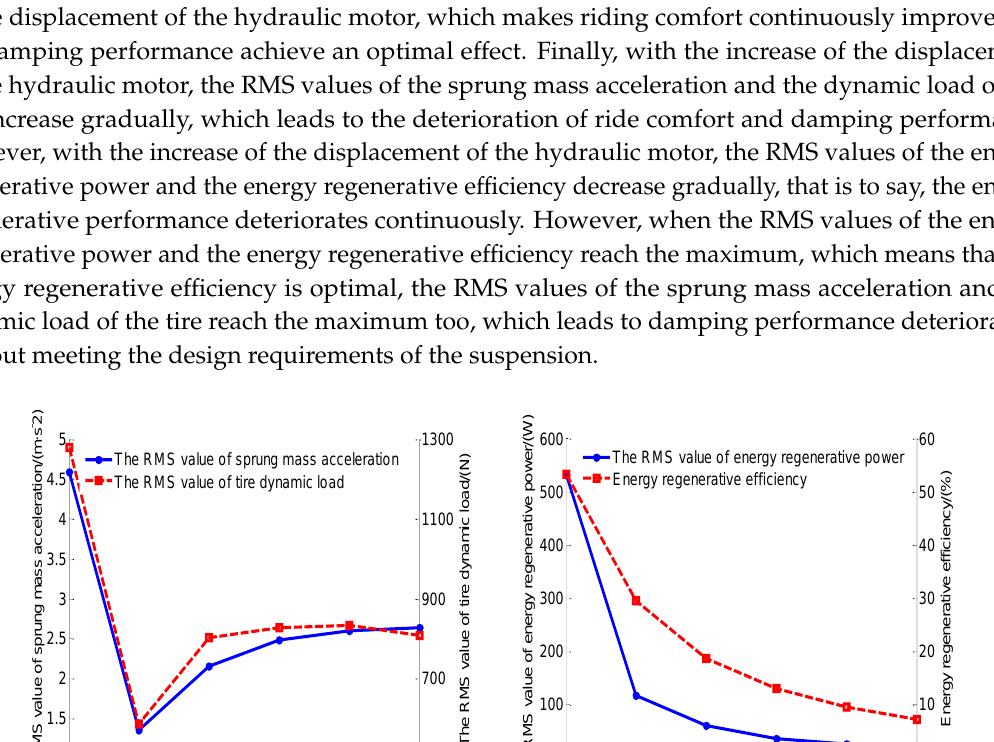
Figure 7. Influence of the displacement of the hydraulic motor on evaluation indicators: ( a ) Influence of the displacement of the hydraulic motor on the damping performance; ( b ) Influence of the displacement of the hydraulic motor on energy regenerative performance.